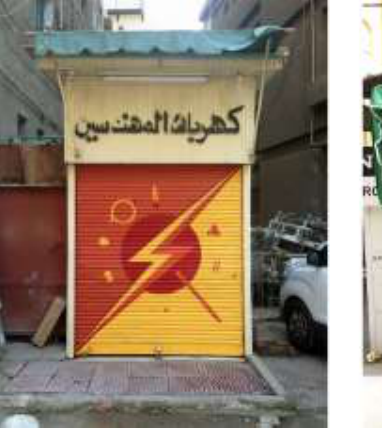
Figure 9 Examples of commercial street